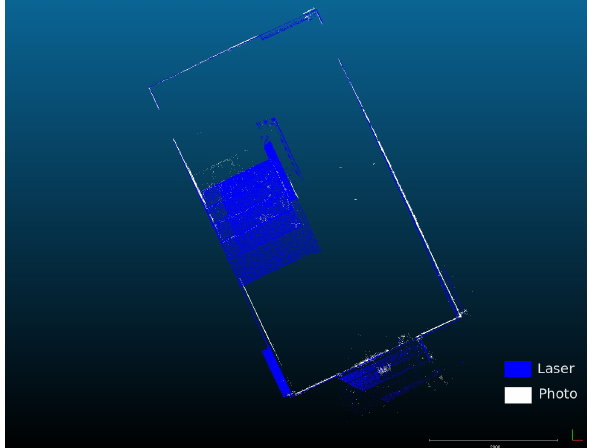
Figure 6: Horizontal section of IBM generated point cloud and TLS point cloud)